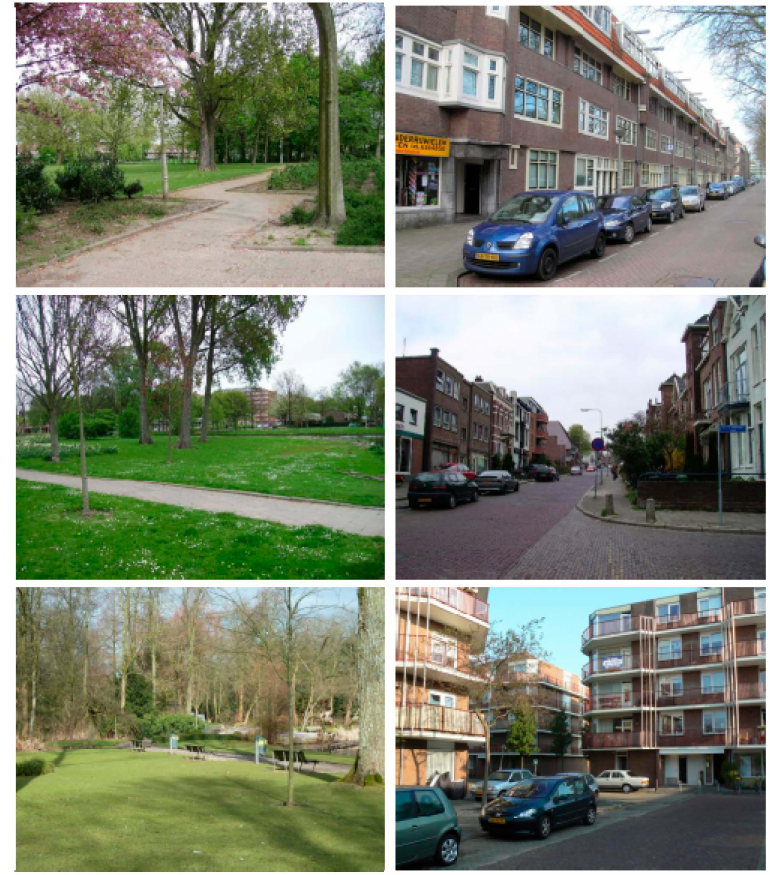
Figure 1. Examples of photos in the green and built stimulus